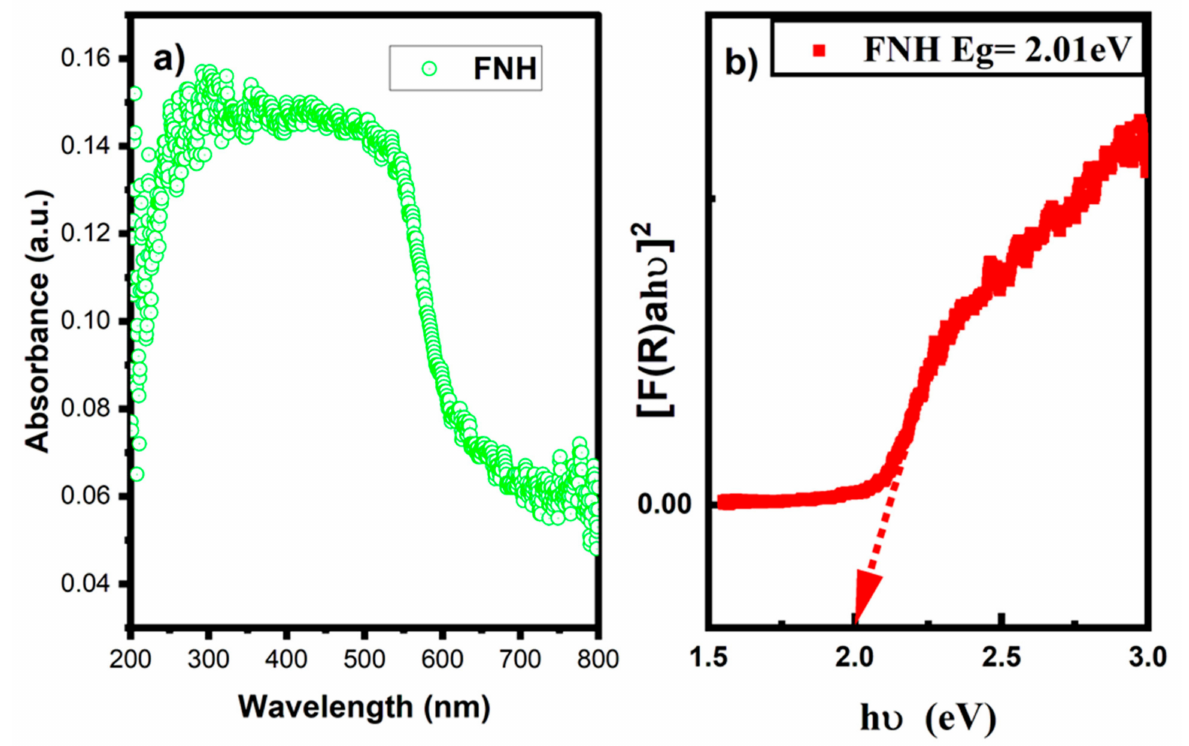
Figure 6. ( a ) UV absorbance and ( b ) Tauc plot of FNH nanoparticles.